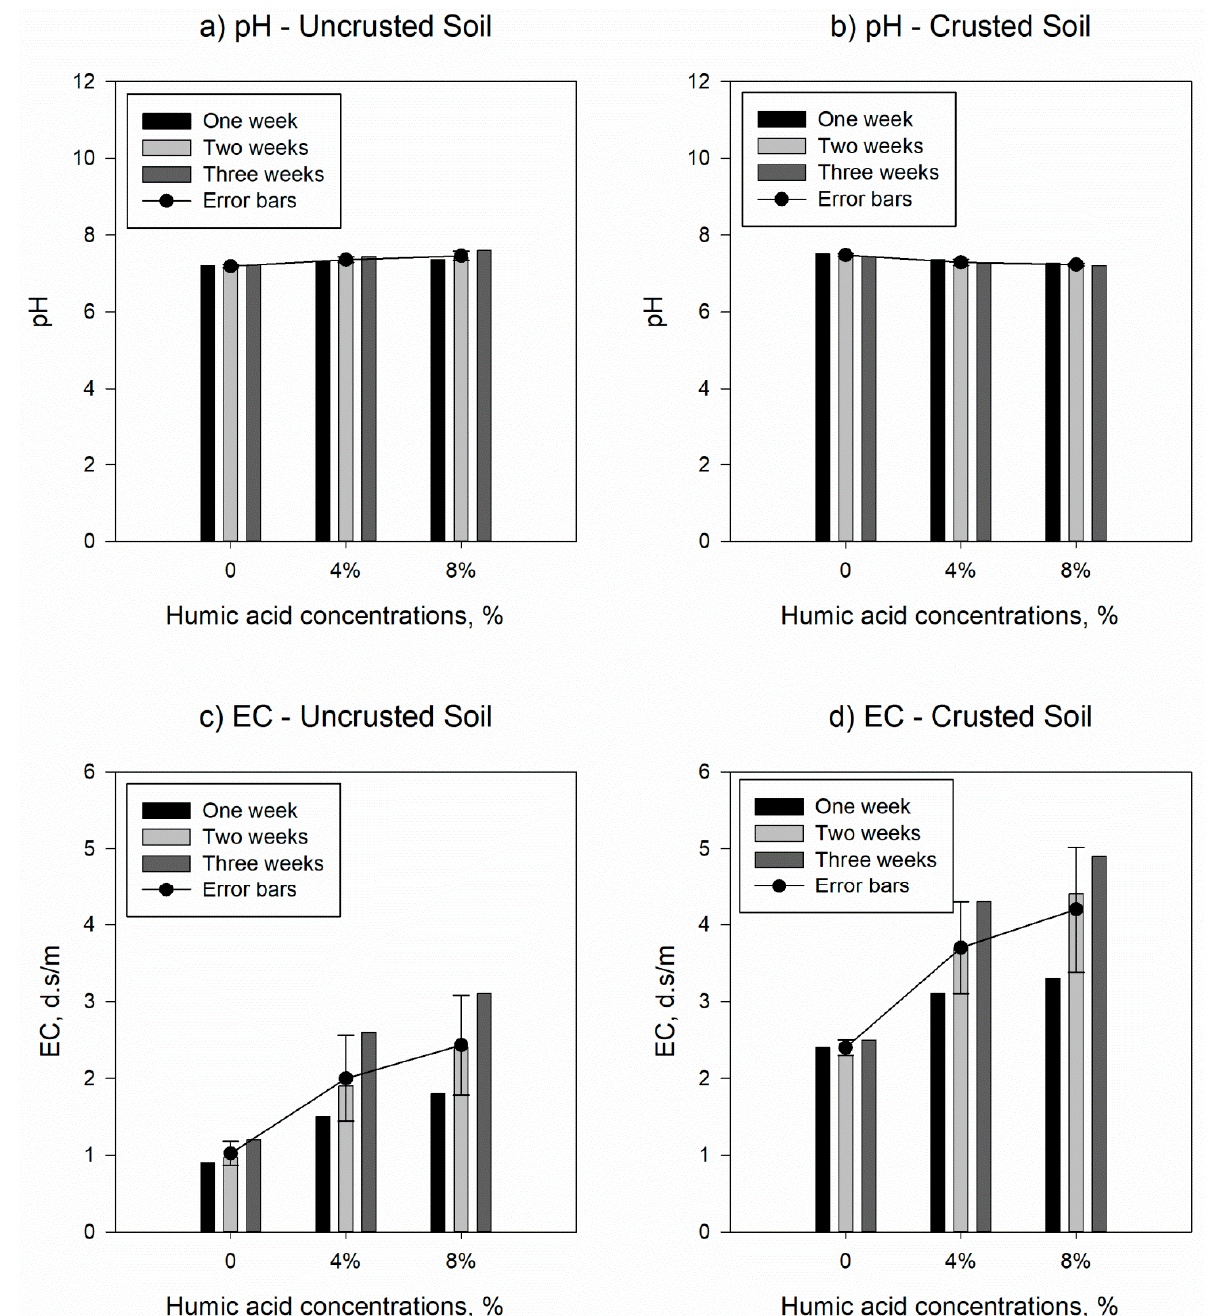
Figure 7. Influence of humic acid concentrations of 0%, 4%, and 8% on: ( a ) soil pH of uncrusted soils, ( b ) soil pH of crusted soils, ( c ) electrical conductivity (EC) of uncrusted soils, and ( d ) electrical conductivity (EC) of crusted soils at different curing times. The error bars are the standard deviations from the mean values of different curing times for each HA